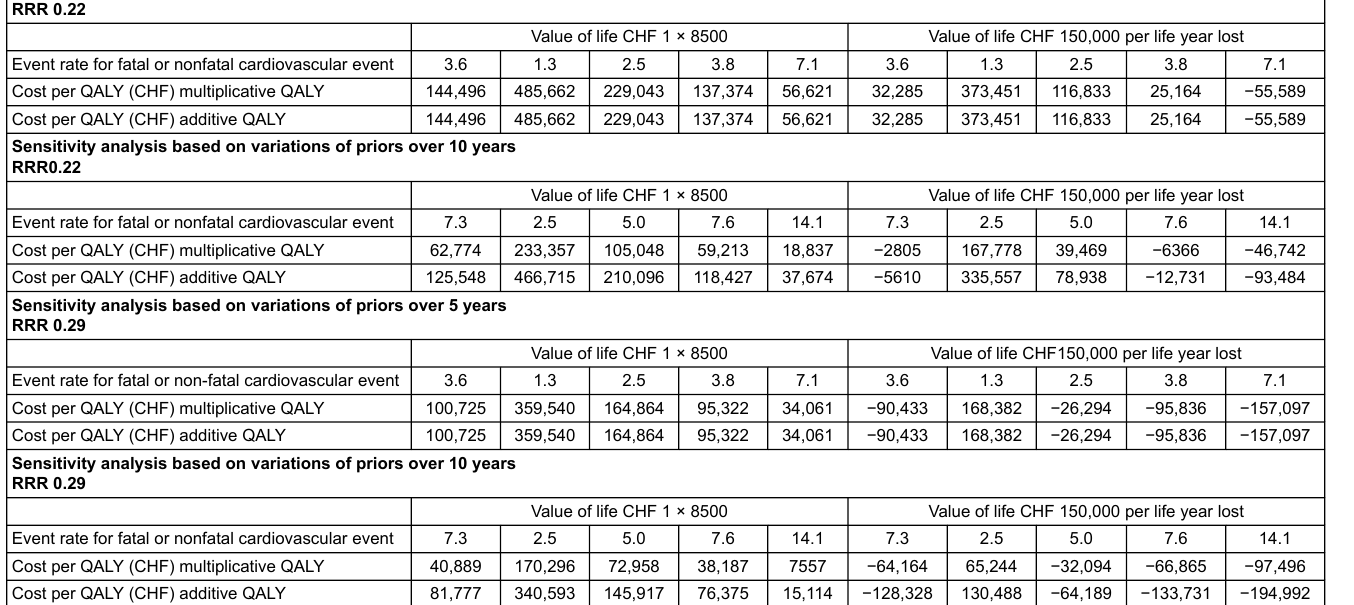
Table S1: Sensitivity for various thresholds of cardiovascular risk, duration of therapy, statin effects (RRR), and QALY model. Sensitivity analysis based on variations of priors over 5 years RRR 0.22